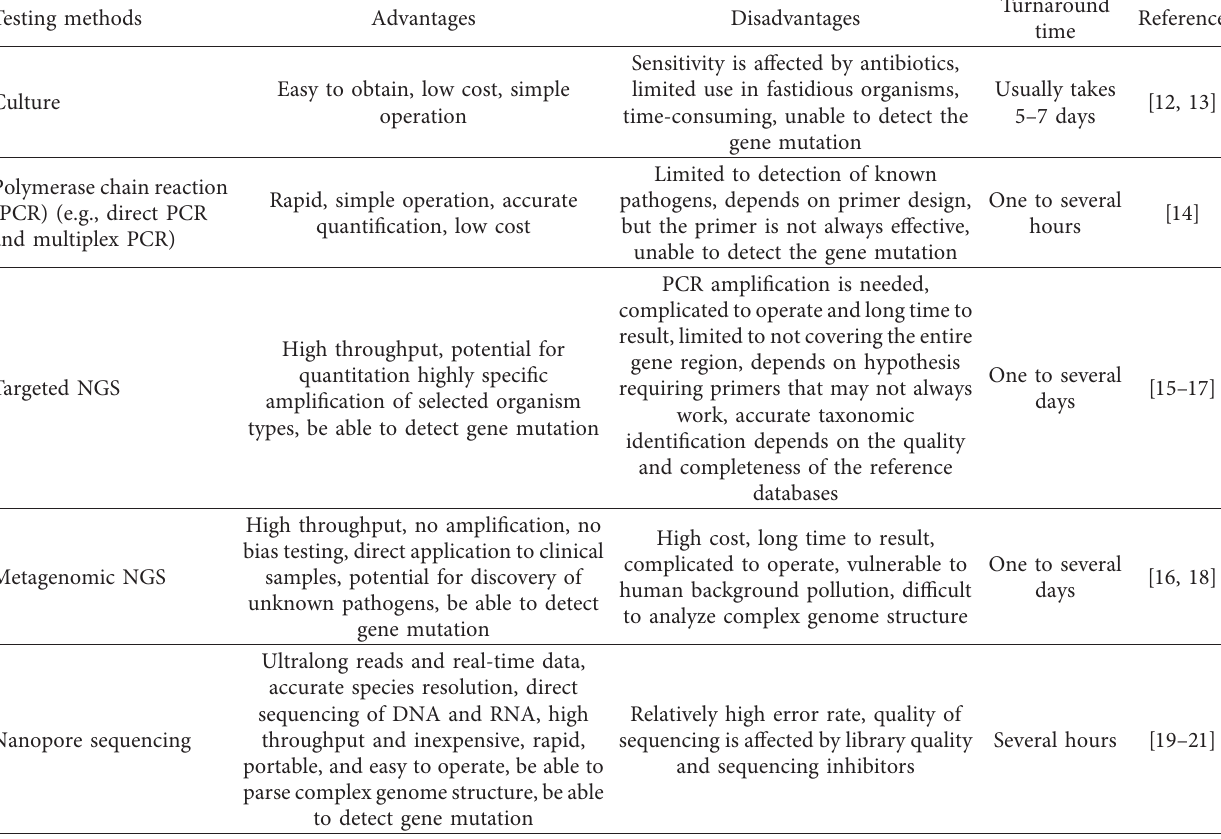
Table 1: Advantages and disadvantages of common pathogen detection